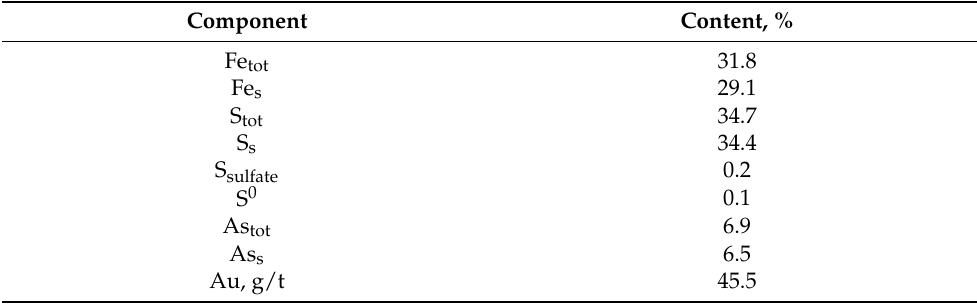
Table 1. Chemical composition of the concentrate.